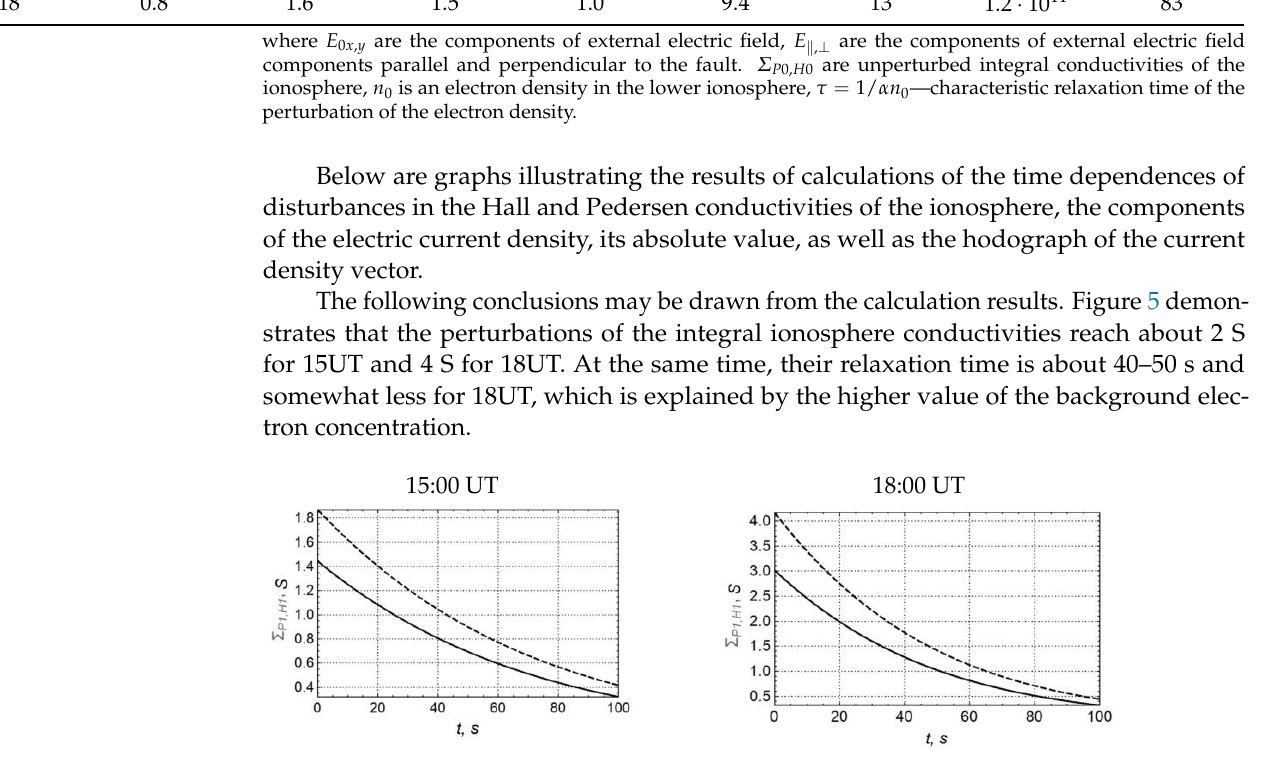
Figure 5. Time dependence of perturbation of ionospheric conductivities. The solid line is the Pedersen conductivity, the dotted line is the Hall conductivity.